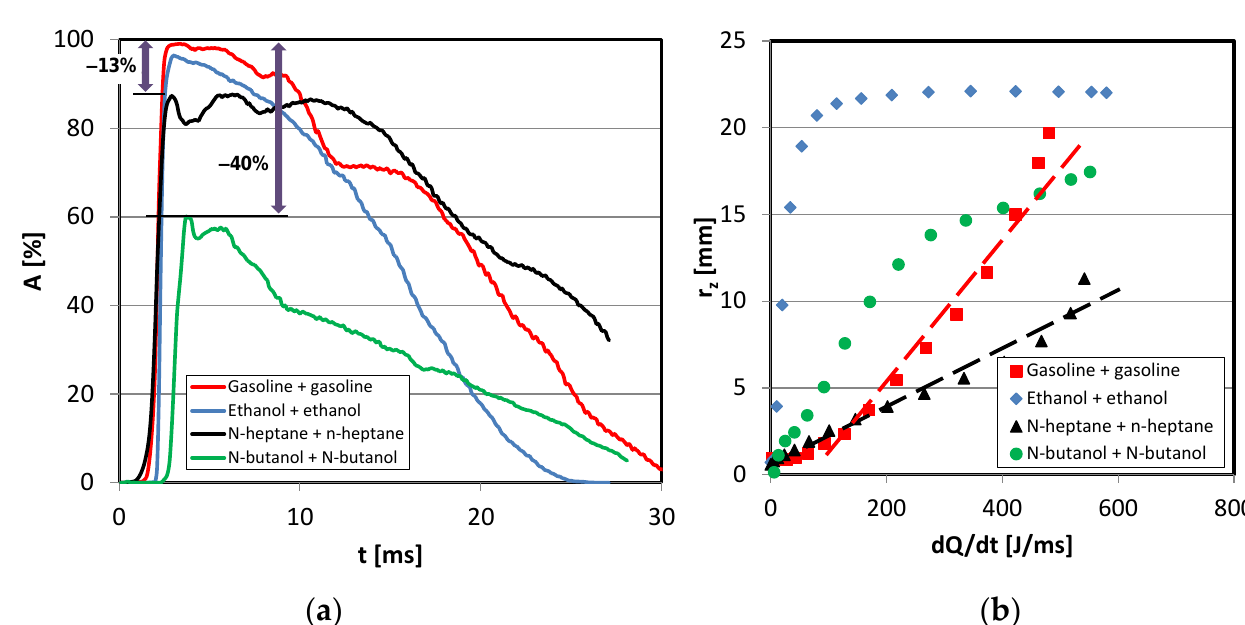
Figure 13. Combustion process indicators for the same fuels: ( a ) comparison of the time characteristics of the percentage share of the combustion chamber cross-sectional area occupied by the flame for the combustion of a single fuel type supplied with both injectors; ( b ) the relationship between the equivalent radius of the flame area and the heat release rate during the combustion of single fuel types supplied with both injectors.